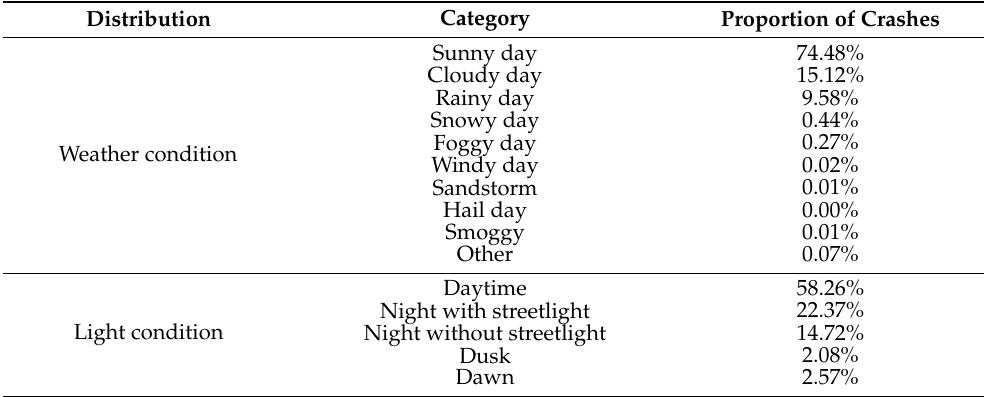
Table A2. The distribution of weather conditions and light conditions in road collisions in China.